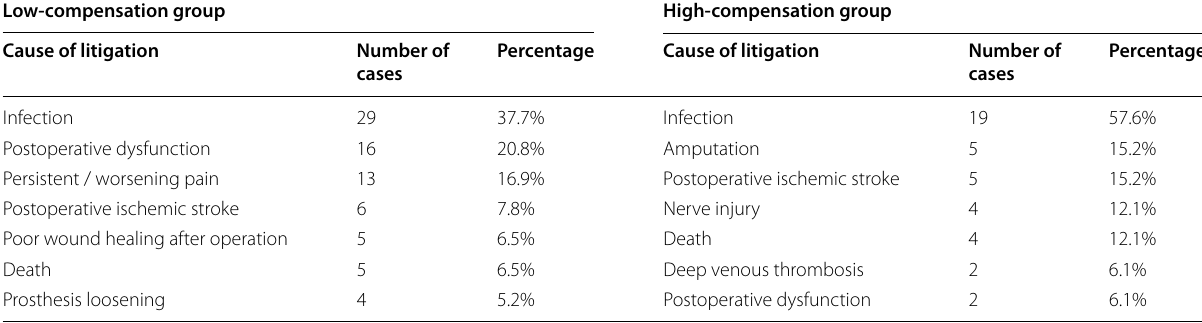
Table 6 Differences in causes of litigation between the high- and low-compensation groups Low-compensation group